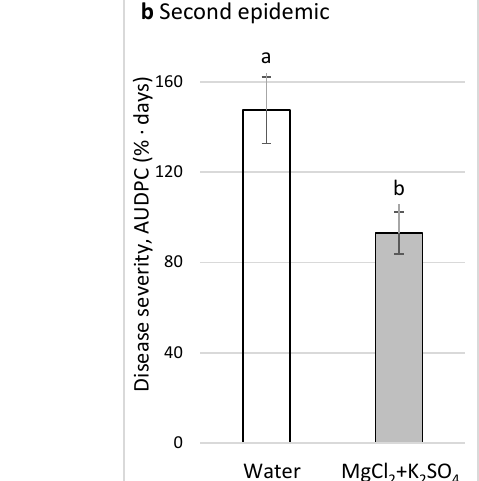
the differences between treatments were insignificant; hence, the detailed yields are not presented.